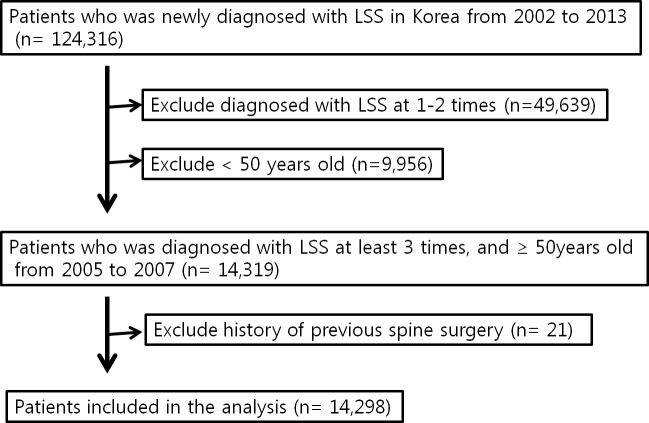
Flowchart of the study population.LSS, lumbar spinal stenosis.